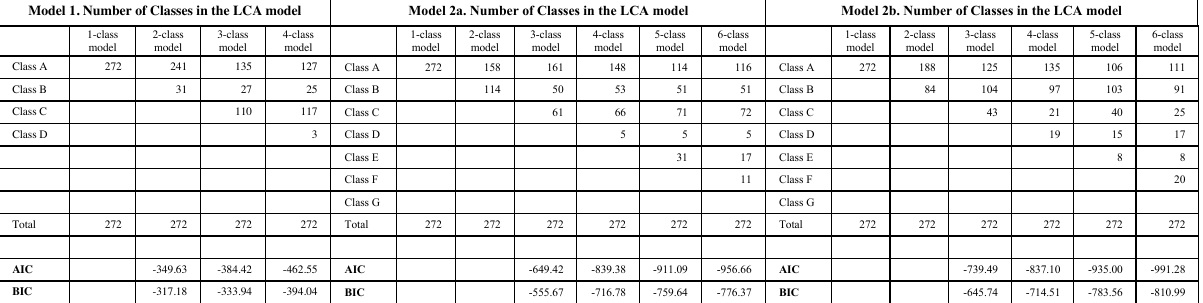
Table 2. Fit Statistics of Model 1, Model 2a, and Model